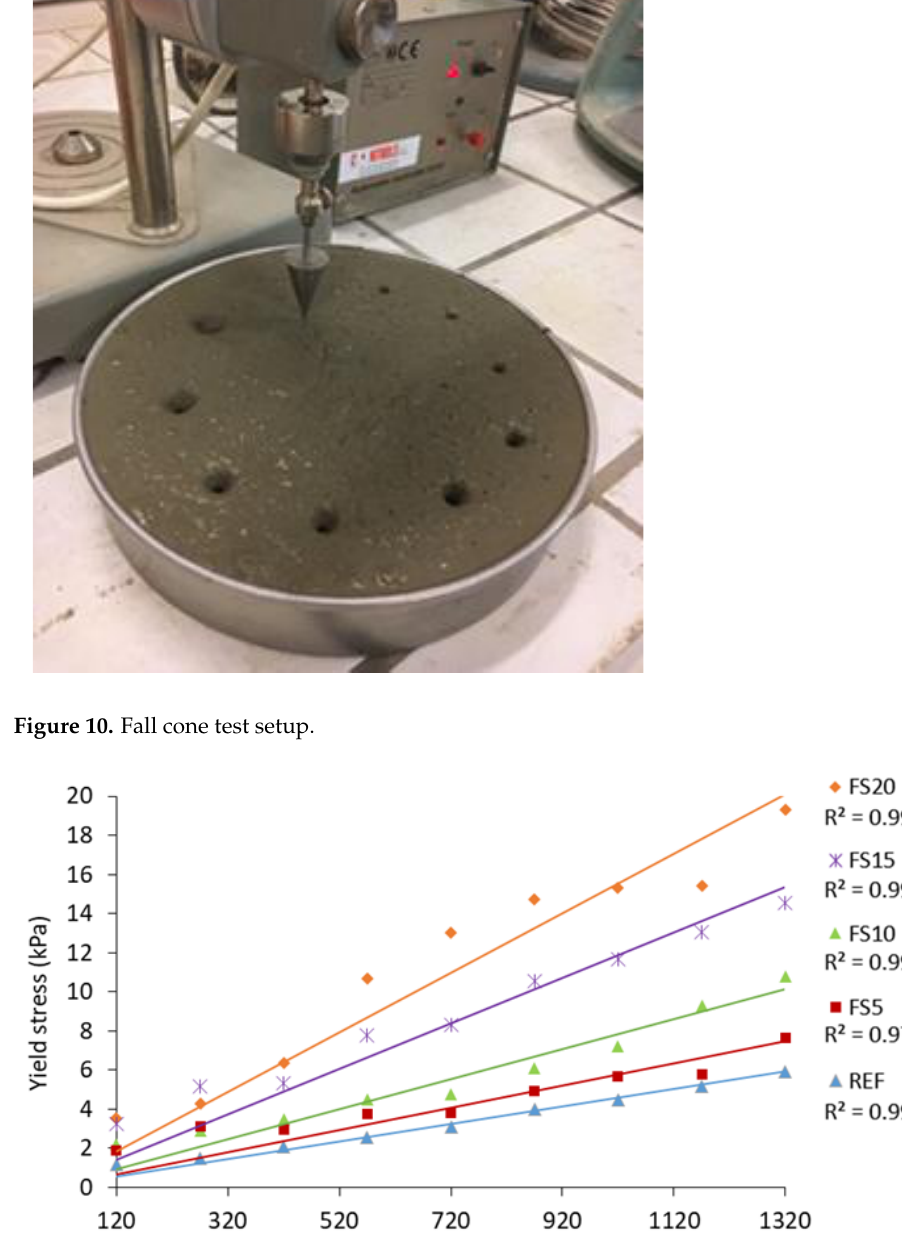
Figure 11. Yield stress evolution of mortars with time.